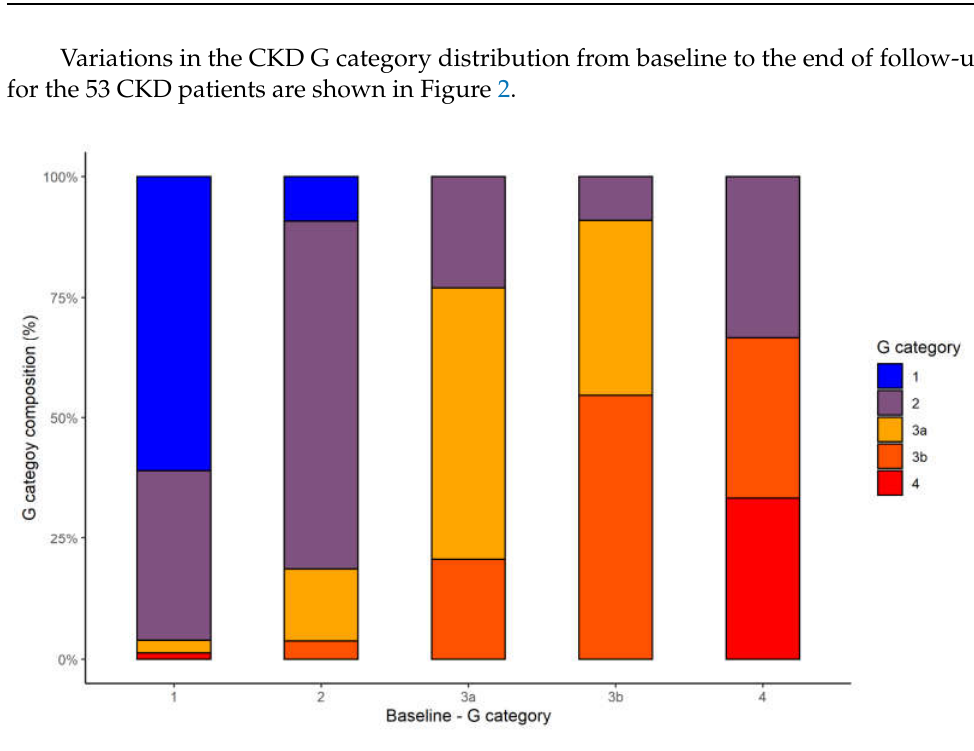
Figure 2. CKD G category distribution at the end of treatment according to the baseline category.